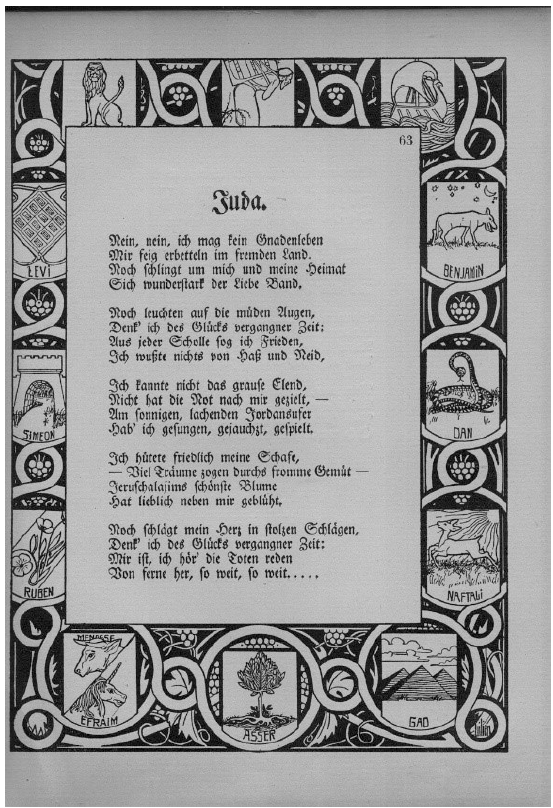
Figure 15. E.M. Lilien, illustration for the poem “Juda” from Morris Rosenfeld, Lieder des Ghetto , translated by Berthold Feiwel (Berlin: Seeman, 1902), p. 63.